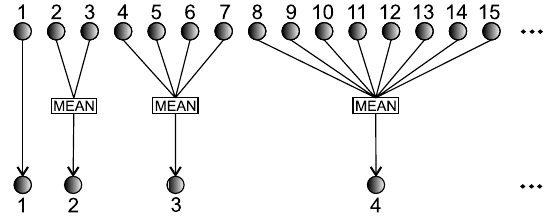
Fig. 8. Principle of exponential clustering and averaging (exponent